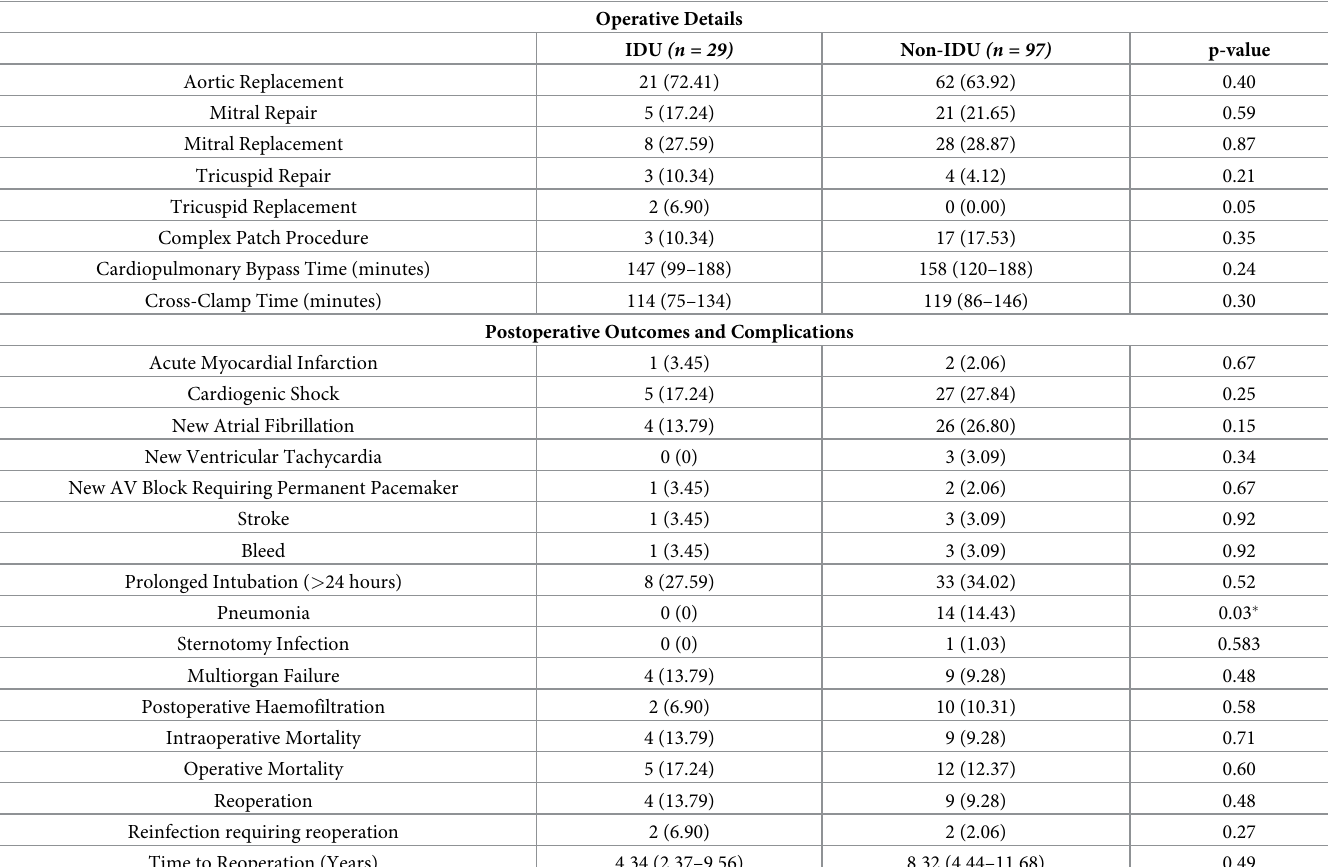
Table 2. Operative details and postoperative outcomes. All categorical data is displayed as total number with percentage proportion in brackets. Continuous data is dis- played as median with IQR in brackets. Statistical significance was determined using unpaired t-test for continuous variable, chi-square test for categorical variables with a sample size over five, and Fisher’s exact test for categorical variables with a sample size equal to or less than